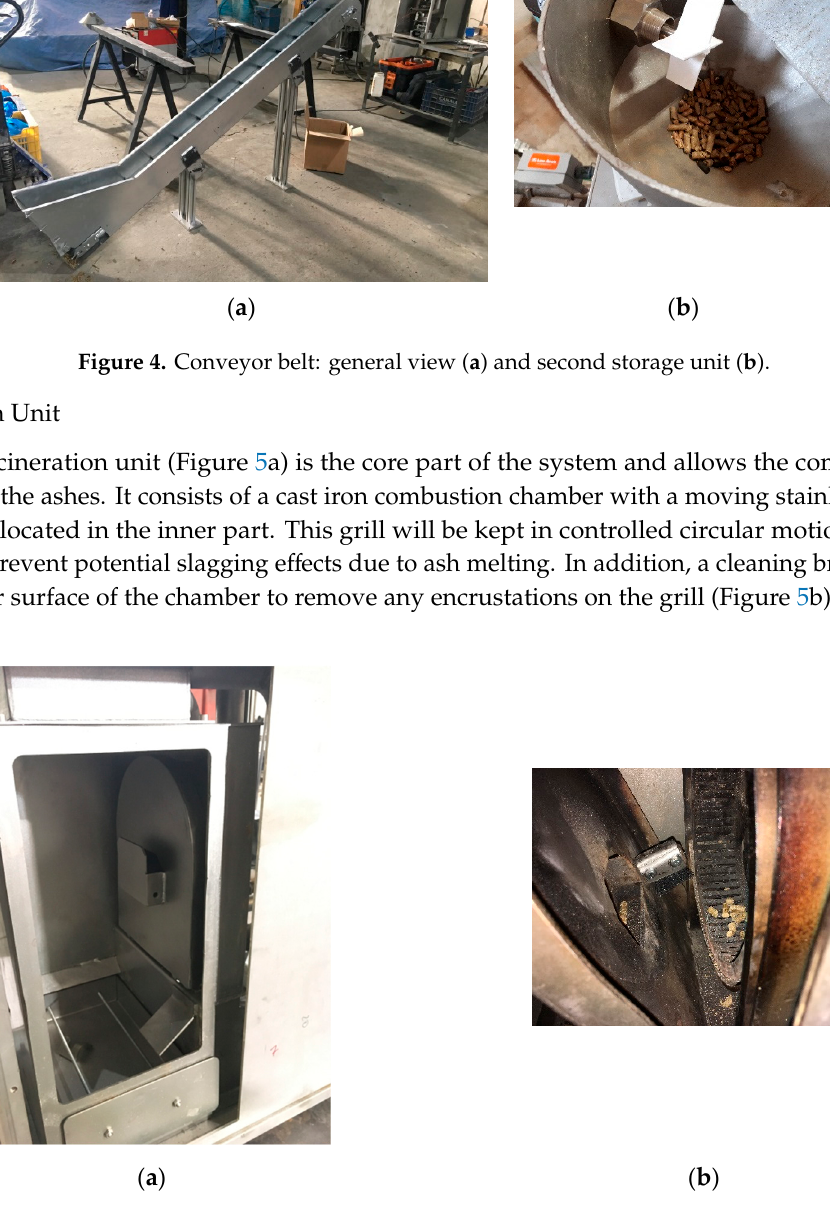
Figure 5. Incineration unit: combustion chamber ( a ) and rotary grill and cleaning brush ( b ).